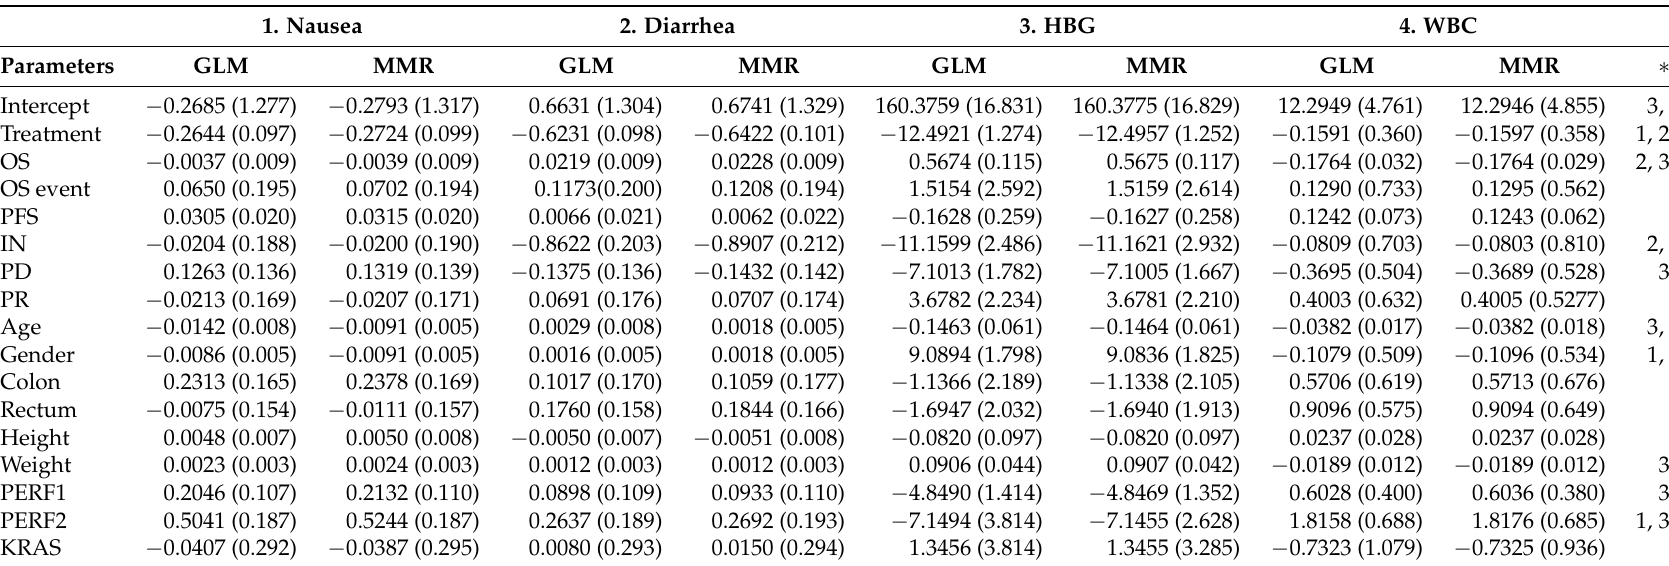
Table A1. The estimated regression coefficients β and the standard deviation (sd). GLM: the estimation via the generalized linear model; MRM: estimation via proposed multivariate mixed response model; the column of ∗ lists the significant